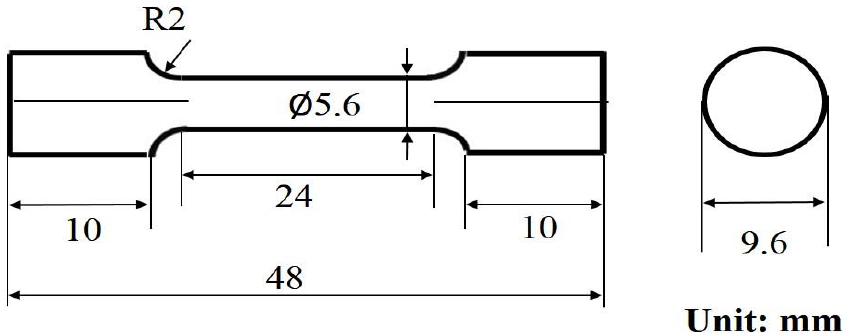
Figure 3. Schematic illustration of the tensile rod specimen.